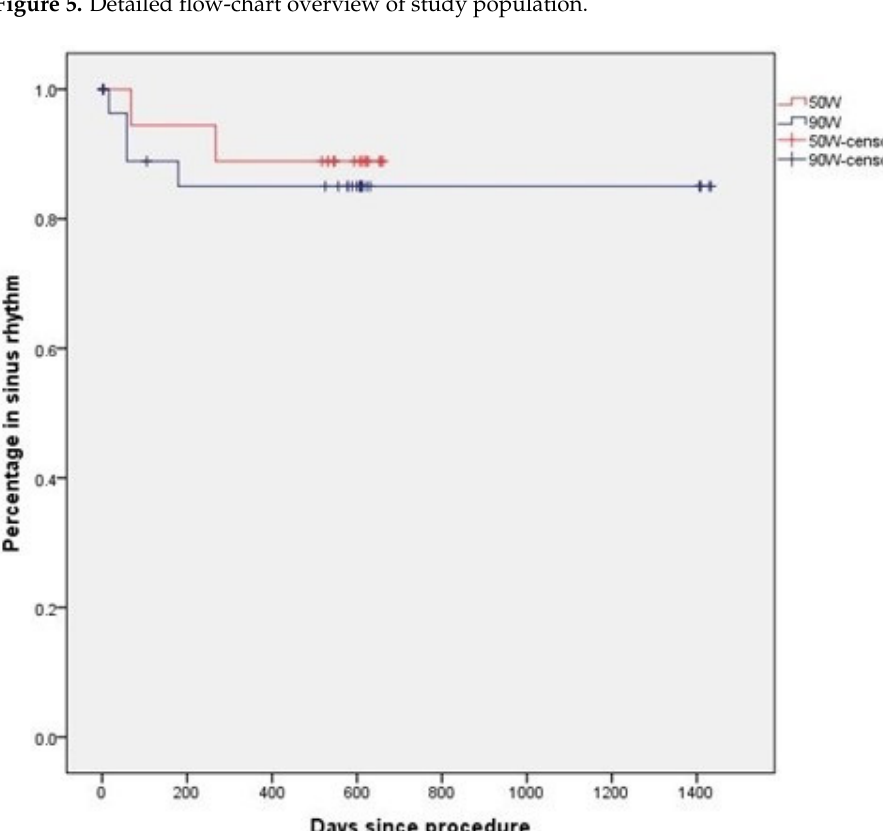
Figure 6. Kaplan Meier Curve outcome analysis- days from intervention to first Afib recurrence.